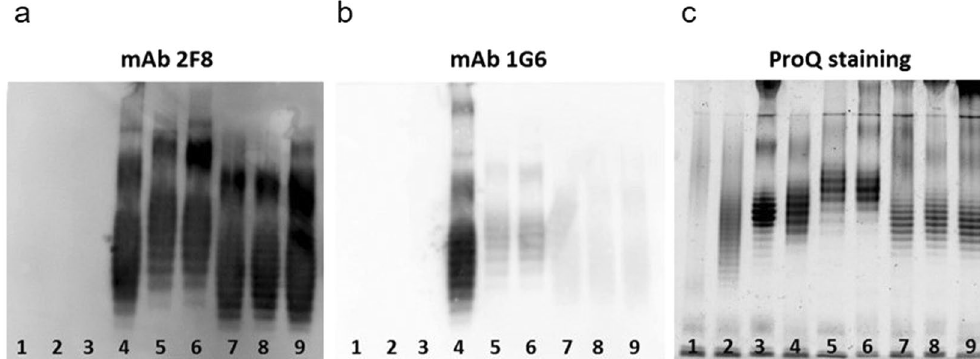
Figure 1. Immunoblot ( a , b ) and ProQ staining ( c ) of LPS samples. LPS was purified from different O3 (lanes 4–9) and unrelated serotype (lanes 1–3) strains of K. pneumoniae . Immunoblots were performed with 1 μ g/ml of mAbs 2F8 ( a ) or 1G6 ( b ). Lane 1: ATCC43816 (O1:K2), 2: PCM-27 (O2:K27), 3: Kp108 (O5), 4: PCM-11, 5: Kp14, 6: Kp62, 7: Kp18, 8: Kp35, 9: